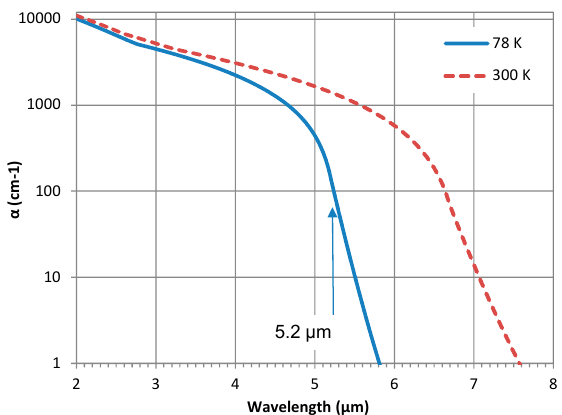
Figure 2. Measured absorption coefficient spectra of the InAs/InAsSb SLS at 78 and 300 K.